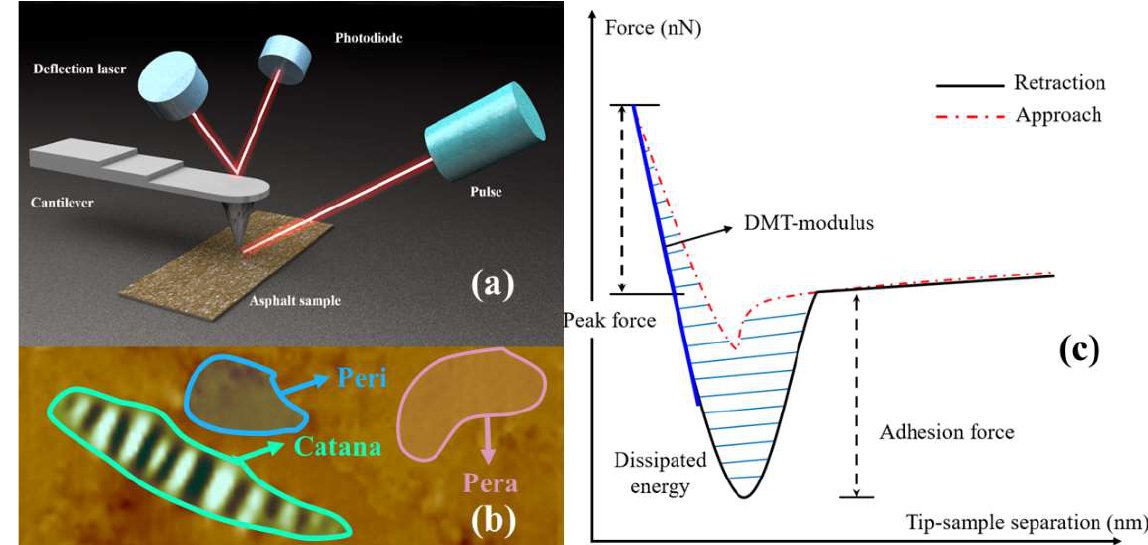
Figure 3. Operational principles of AFM: ( a ) operational principle of AFM; ( b ) schematic diagram of the three phases; ( c ) schematic force curve.